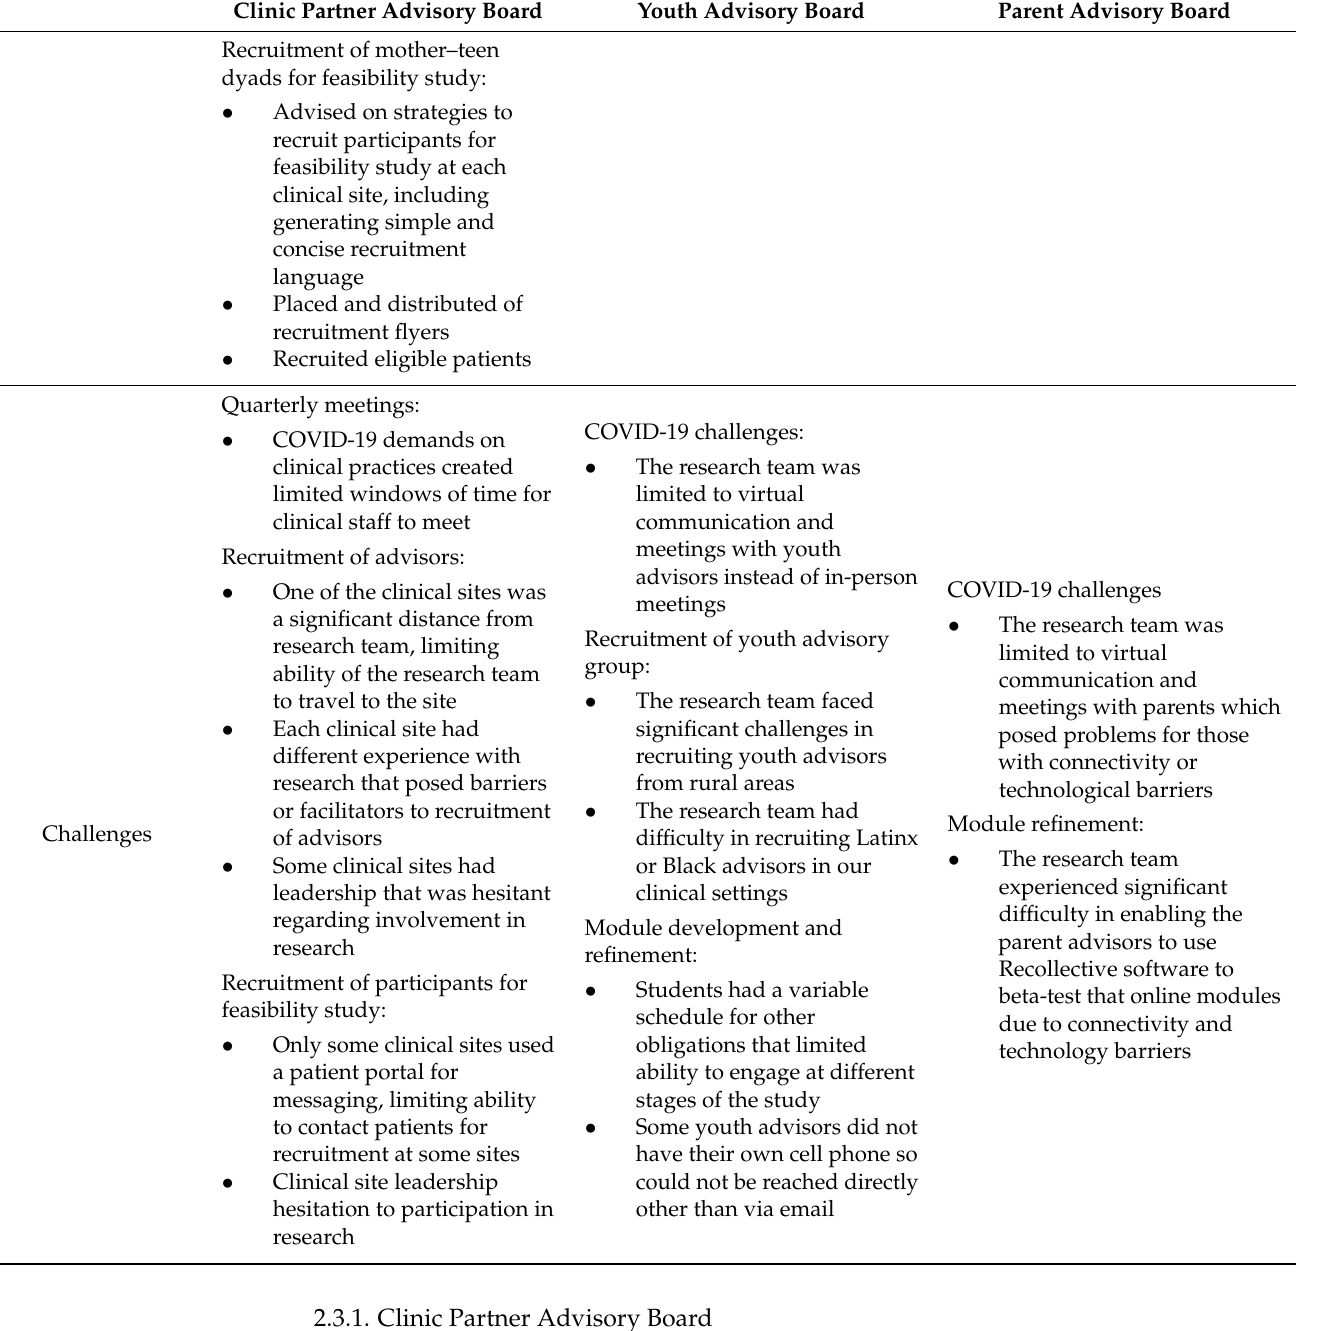
Table 2. Cont. Clinic Partner Advisory Board Youth Advisory